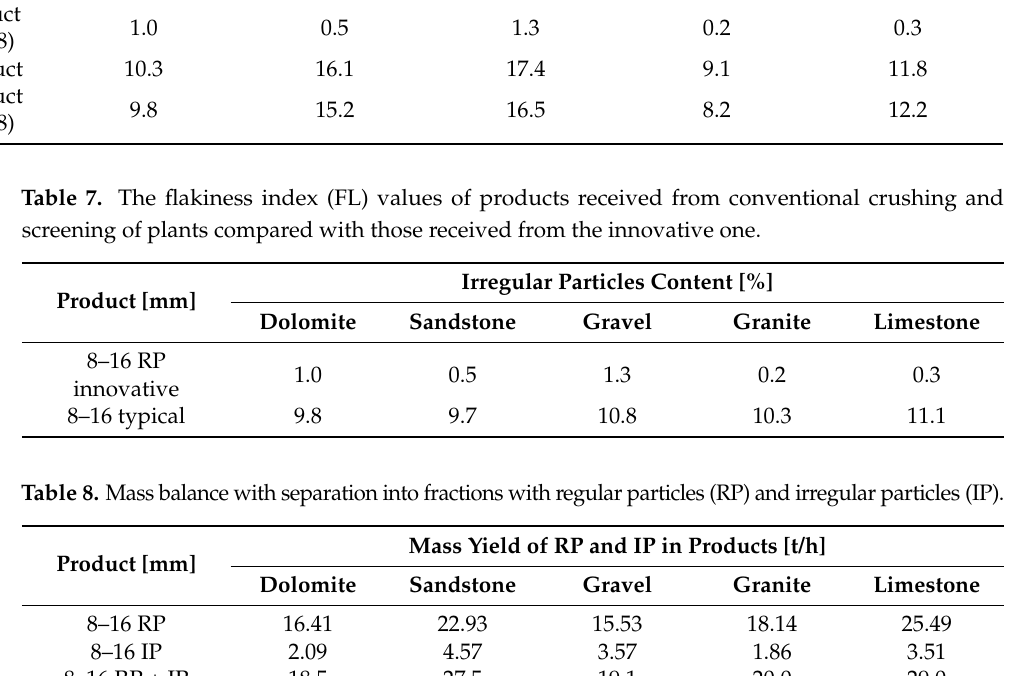
Table 6. The flakiness index FI for the five final products of 8–16 mm of the Formator technological system. Irregular Particles Content [%] Product [mm] Dolomite Sandstone Gravel Granite Limestone